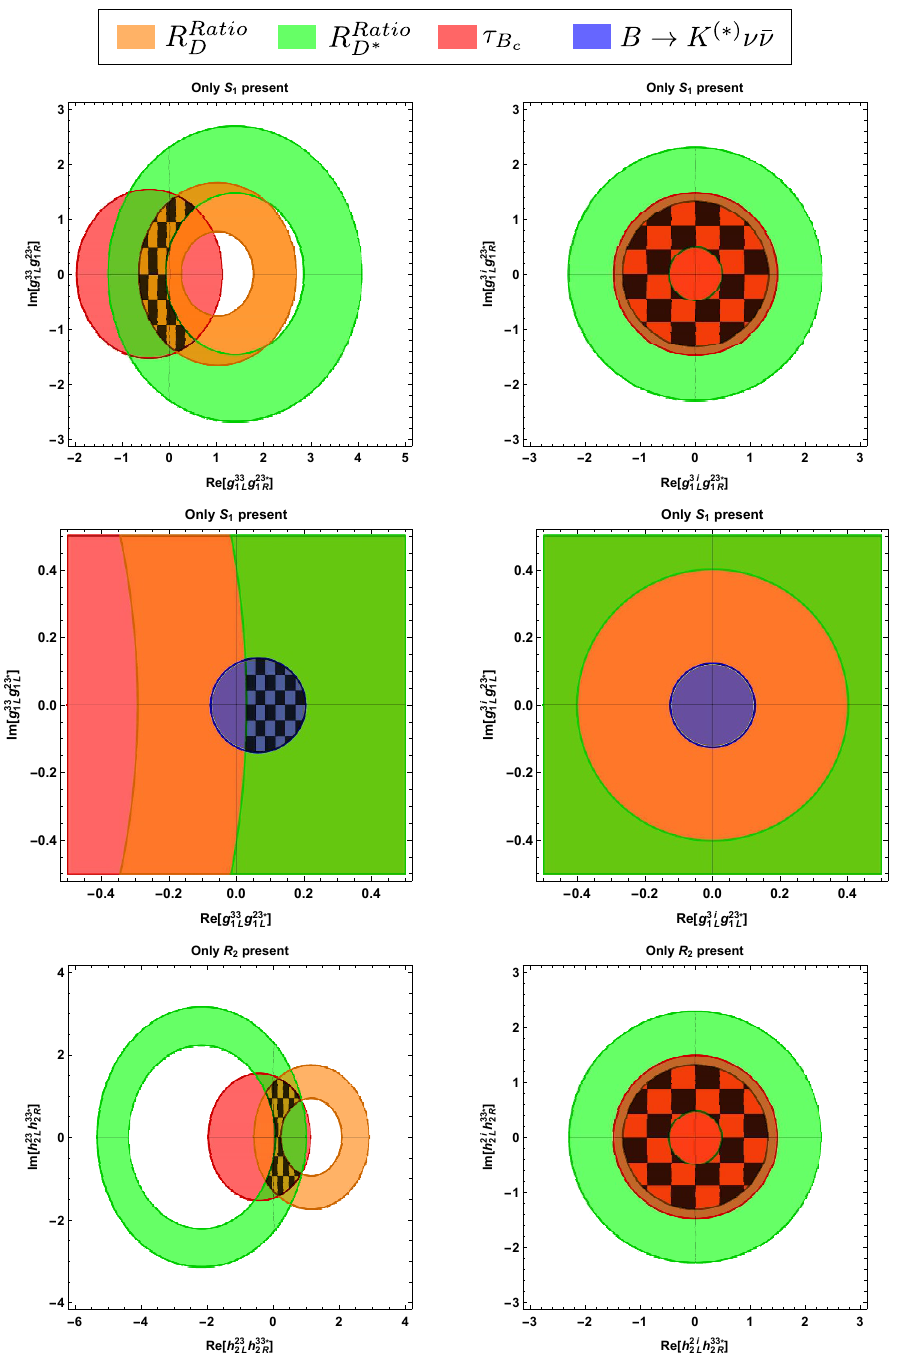
Figure 7 . Constraints on the S 1 and R 2 leptoquark models when considering one coupling at a time. Here, i = 1 , 2 denotes the electron and muon neutrinos. We require that the couplings reproduce the measurements of R Ratio and R Ratio in eqs. (1.7) and (1.8) within 3 σ , satisfy ( B c τ − ¯ ν τ ) 30%, D D ∗ B → ≤ and are consistent with the upper bounds on ( B K ( ∗ ) ν ¯ ν ) at 90% C.L. The allowed regions of B → the parameter space when combining all constraints are highlighted with a black